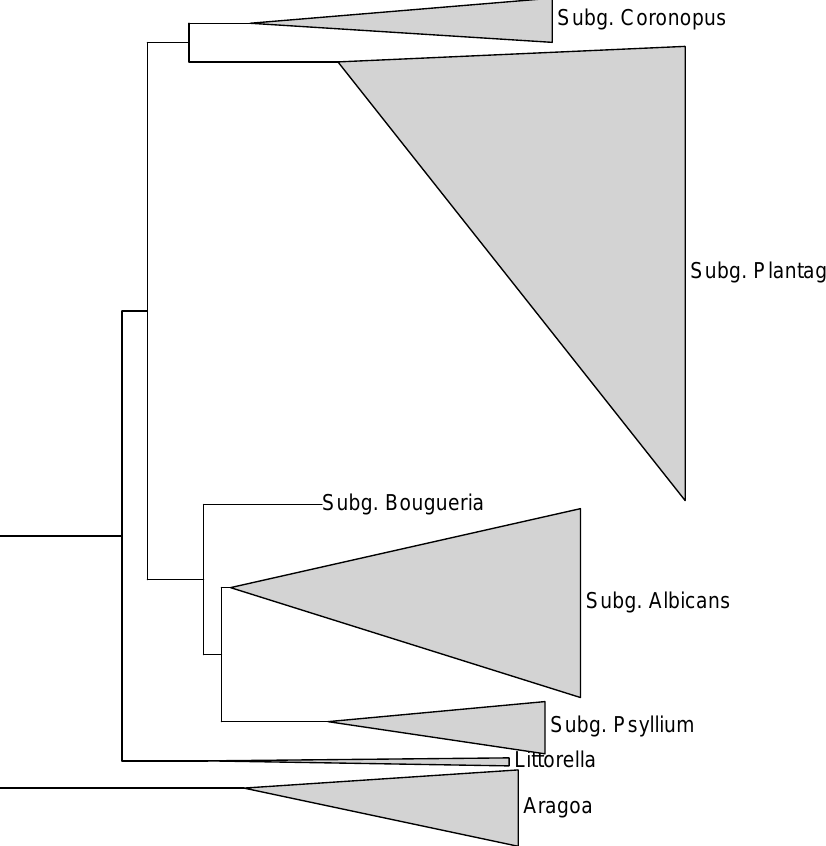
Figure 1. Phylogeny of the Plantagineae: general arrangement of clades (genera and subgenera). Each triangle is the result of concatenation applied to the branches of the Bayesian (MB) phylogenetic tree; internal branches are collapsed and triangle size represents number of species. Names beginning with “subg.” are subgenera of Plantago